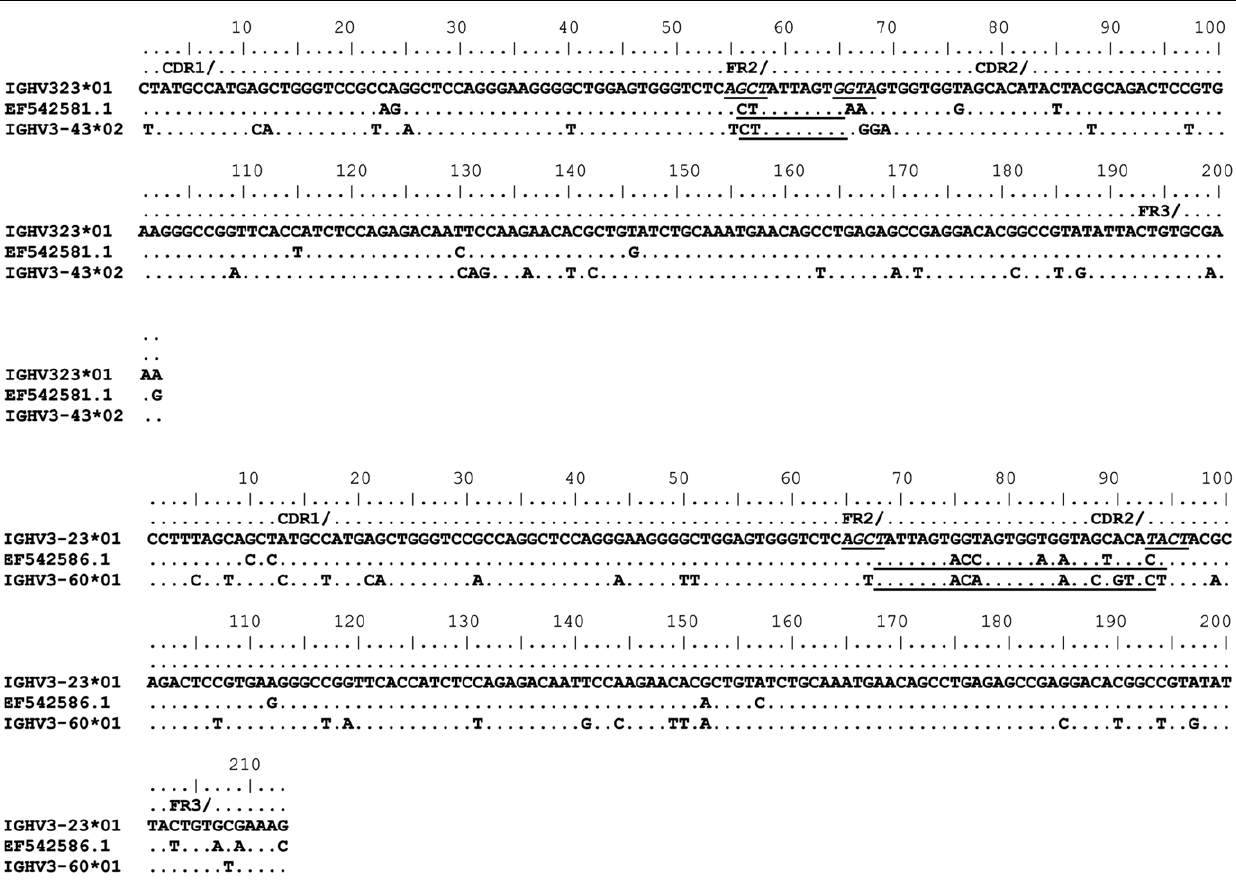
FIGURE 4 | Gene conversion-like events between rearranged IGHV3-23*01 gene sequences and germlineVH sequences superimposed by somatic hypermutation (SHM). IGHV3-23*01 mutated sequences obtained by single-cell PCR from CD19 + IgD + CD27 + B cells (Brezinschek et al., 1995, 1997; Dörner et al., 1998; Longo et al., 2008).Topmost sequence